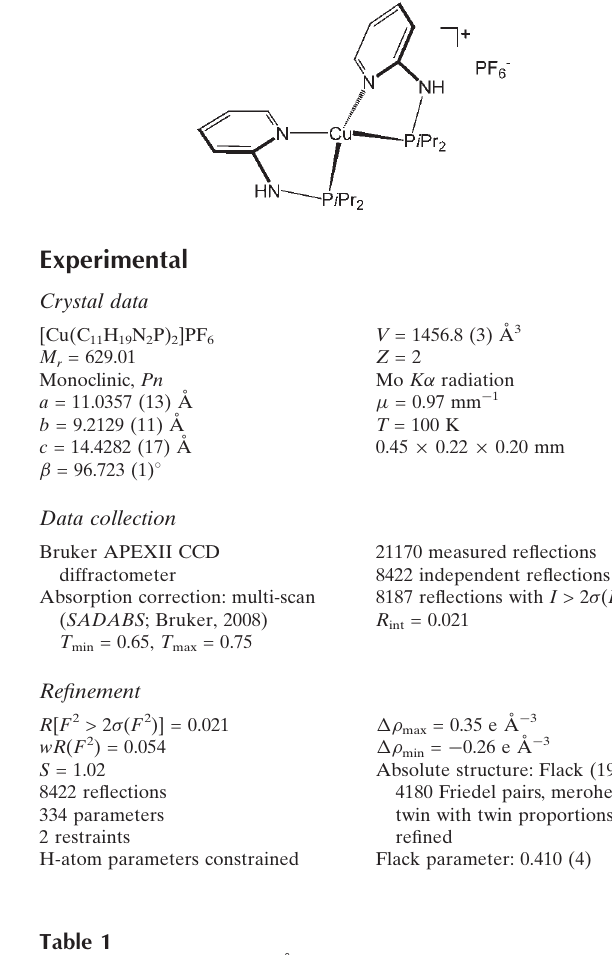
Hydrogen-bond geometry (A˚ , (cid:3)